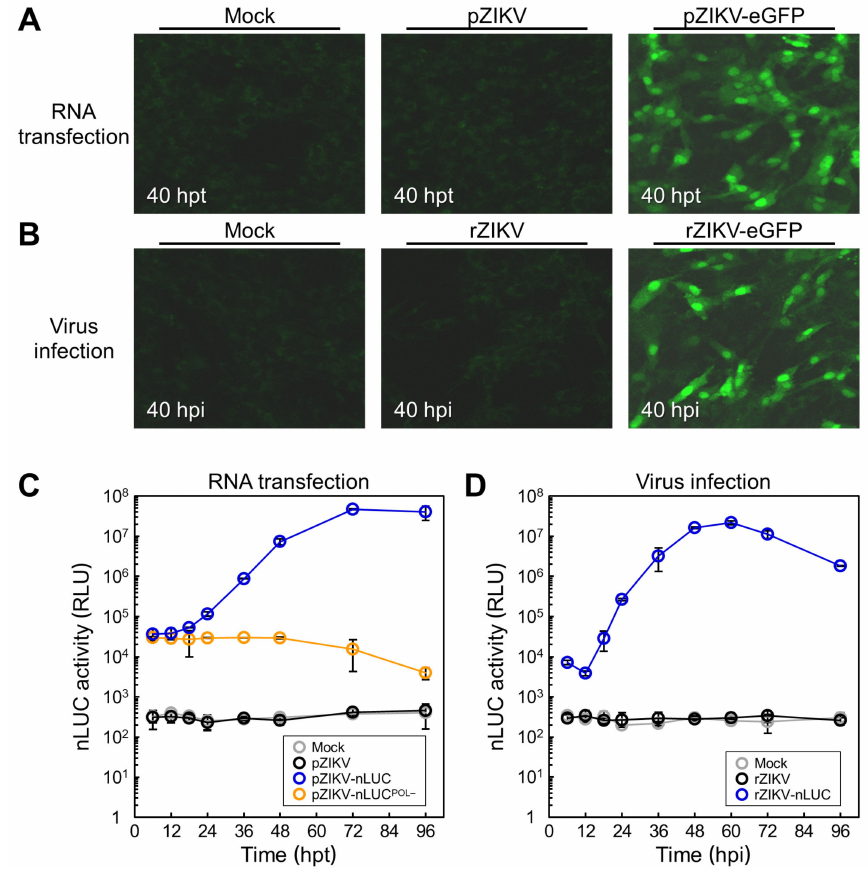
Figure 5. Monitoring of reporter gene expression. ( A , B ) eGFP expression. BHK-21 cells were mock-transfected or transfected with 2 µ g of the in vitro-transcribed RNAs from pZIKV or pZIKV-eGFP ( A ). In parallel, BHK-21 cells were mock-infected or infected with rZIKV or rZIKV-eGFP at a multiplicity of infection (MOI) of 1 ( B ). At 40 h post-transfection (hpt) or post-infection (hpi), cells were fixed and examined by confocal microscopy. Images were acquired using a 20X dry lens (Plan-Apochromat 20X / 0.8 M27). Representative fluorescent images from one of two experiments are presented. ( C , D ) nLUC activity. BHK-21 cells were mock-transfected or transfected with 2 µ g of the in vitro-synthesized RNAs of pZIKV, pZIKV-nLUC, or pZIKV-nLUC POL − ( C ). In addition, BHK-21 cells were mock-infected or infected with rZIKV or rZIKV-nLUC at a MOI of 1 ( D ). During the incubation period of 4 days, cells were lysed at the indicated time points after RNA transfection or virus infection for nLUC assays. The nLUC activity is expressed in relative light units (RLU). Error bars indicate standard deviations of two independent